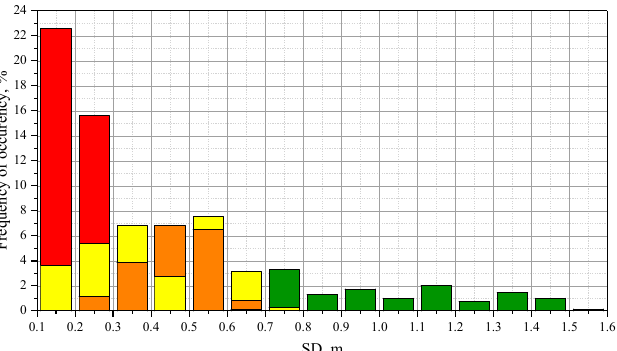
Figure 14. Distribution (%) of standard deviation (sd) per the clusters (red 1st, yellow 2nd, orange 3rd and green 4th clusters).